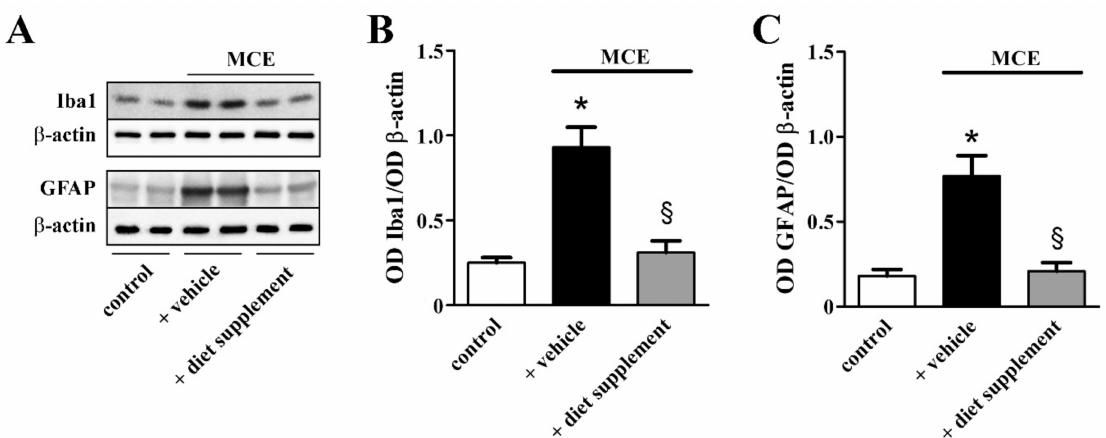
Figure 5. E ff ects of dietary supplementation on glial activation. ( A ) Representative Western blots from retinal homogenates of control mice or mice that received MCE fed with either vehicle or diet supplement. ( B , C ) Densitometric analysis of ionized calcium binding adaptor molecule 1 (Iba1; ( B